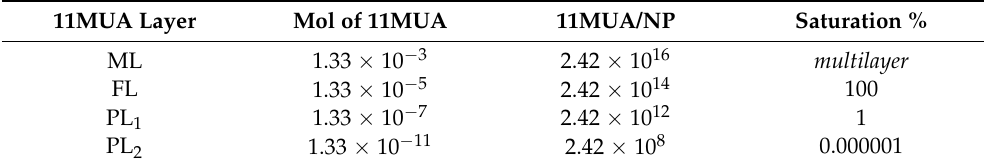
Table 1. The number of moles of 11MUA added to the AgNP suspension for the functionalization, cor- responding number of 11MUA molecules per nanoparticle, and % of saturation for ML = multi-layer, FL = full-layer, and PL 1,2 = partial layers,